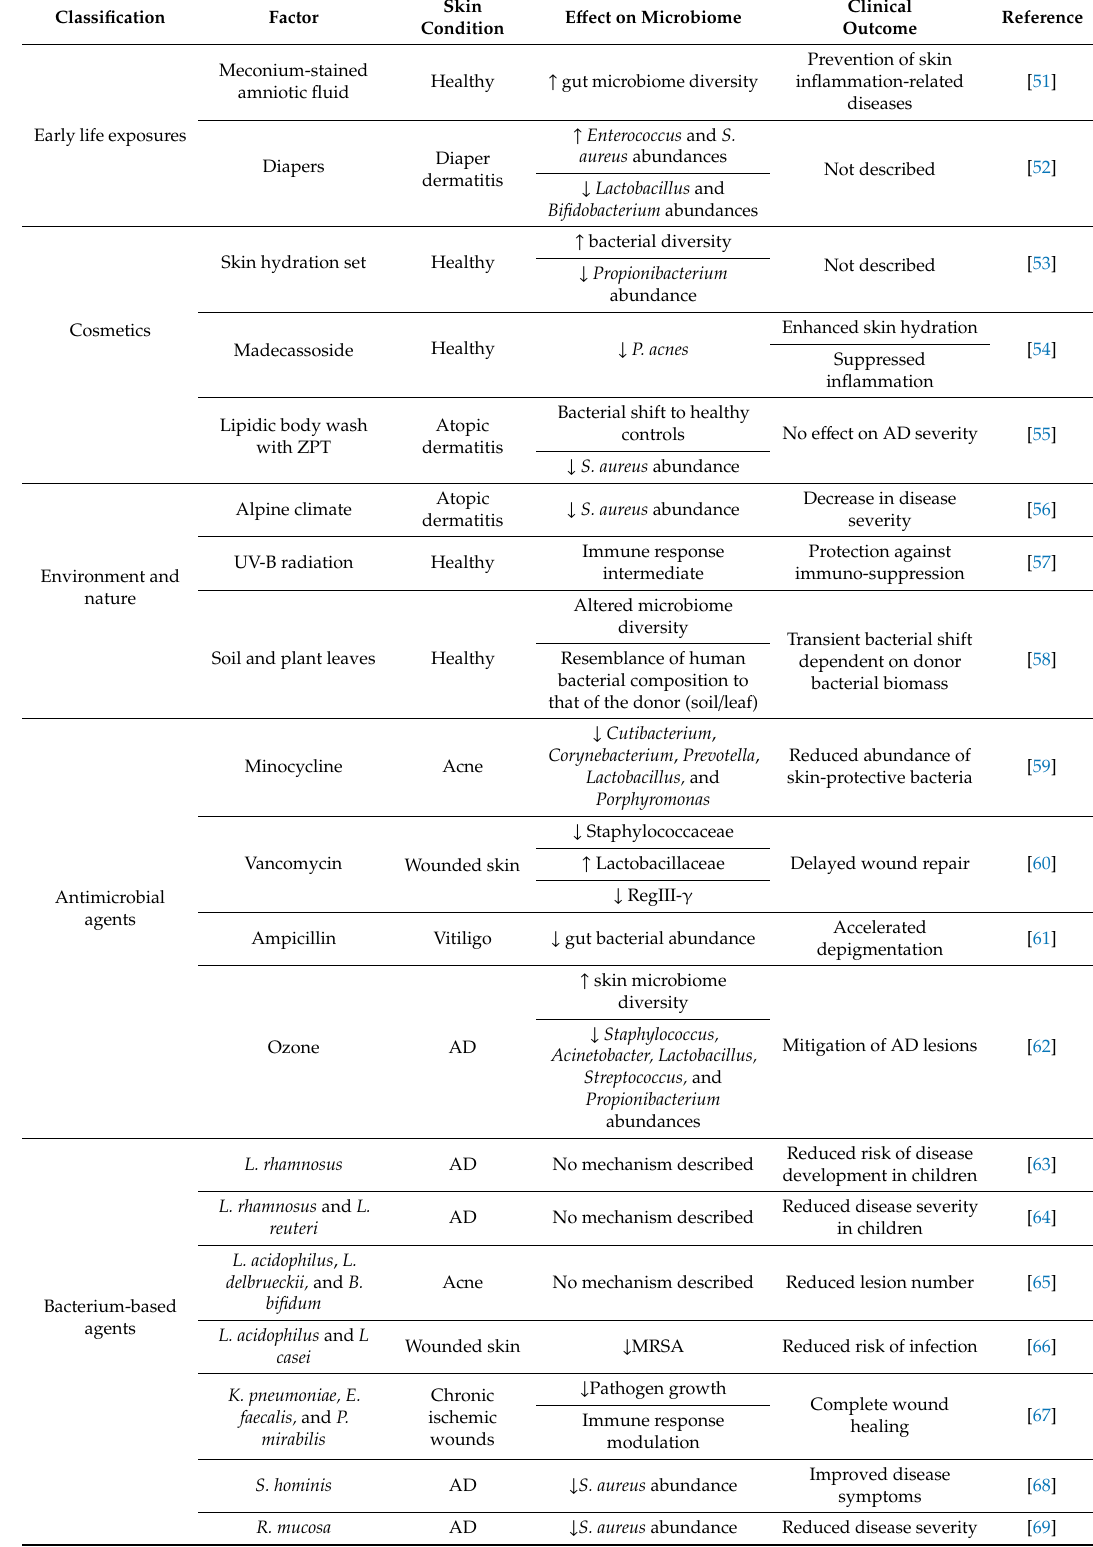
Table 1. Summary of extrinsic factors a ff ecting the skin